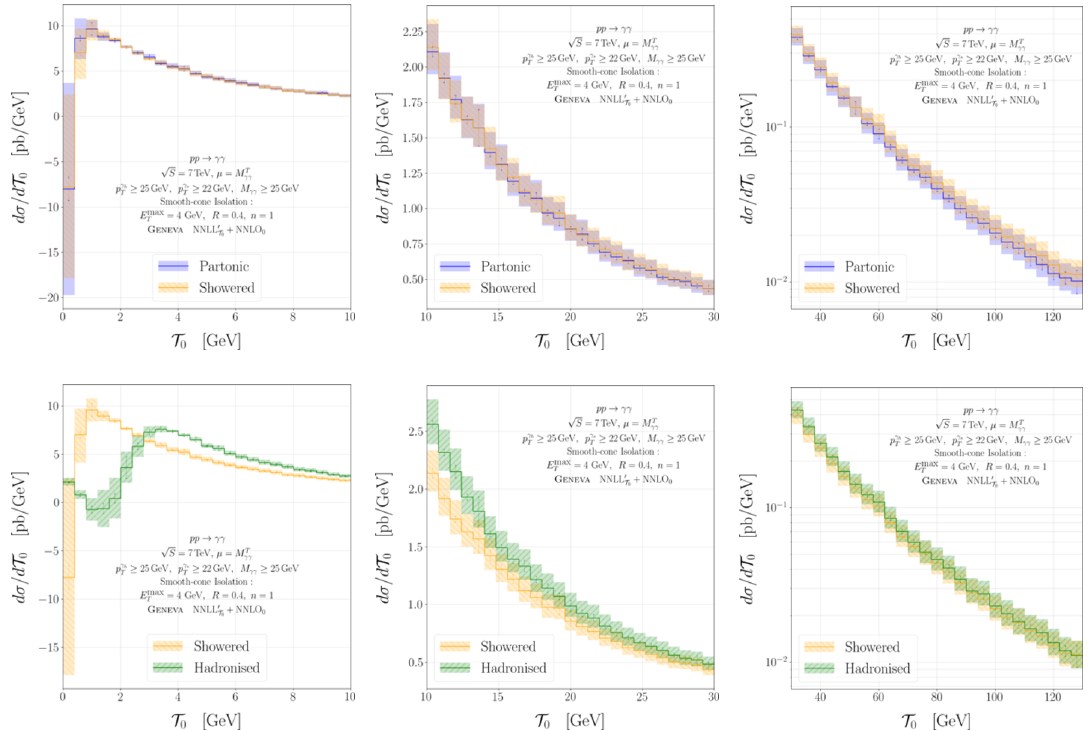
Figure 7 . Comparison of T 0 spectra between the partonic NNLO 0 +NNLL 0 and the showered re- sults, after interfacing to Pythia8 , before the inclusion of non-perturbative effects (above). Com- parison between the showered and hadronised T 0 spectra (below). The peak (left), transition (centre) and tail (right) regions are